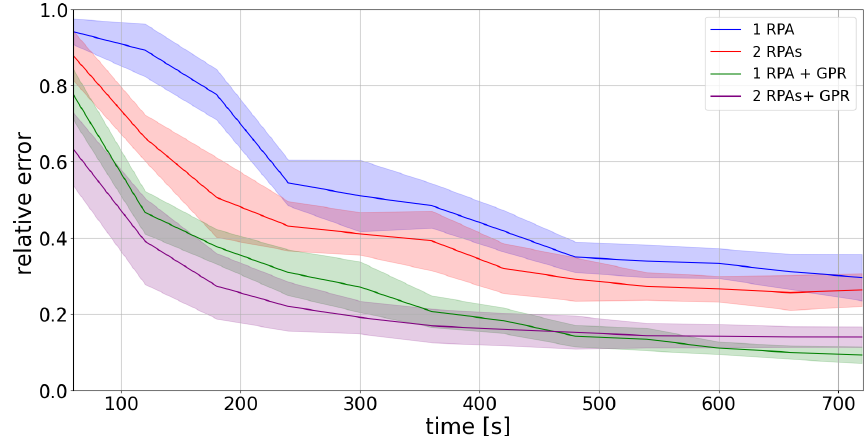
Figure 12. Temporal evolution of relative error in the PDF of the LWC distribution for a single RPA with the transect method (blue line) and GPR mapping (green line) as well as two RPA with the transect method (red line) and GPR mapping (purple line) during the exploration of cloud N2 in static